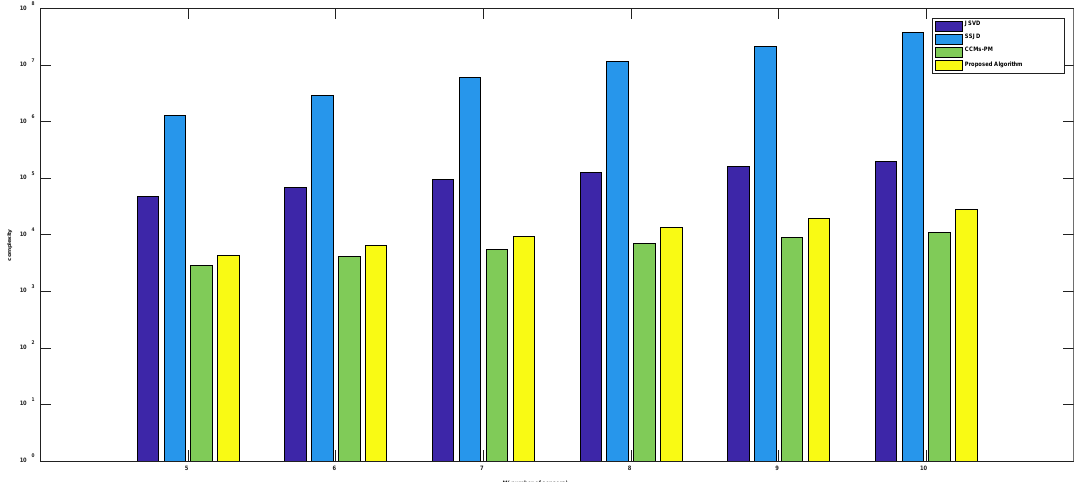
Figure 3. Comparison of complexity versus the number of sensors.